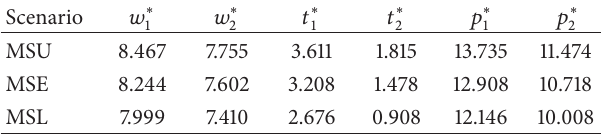
Table 3: The optimal decisions of prices and warranty levels.